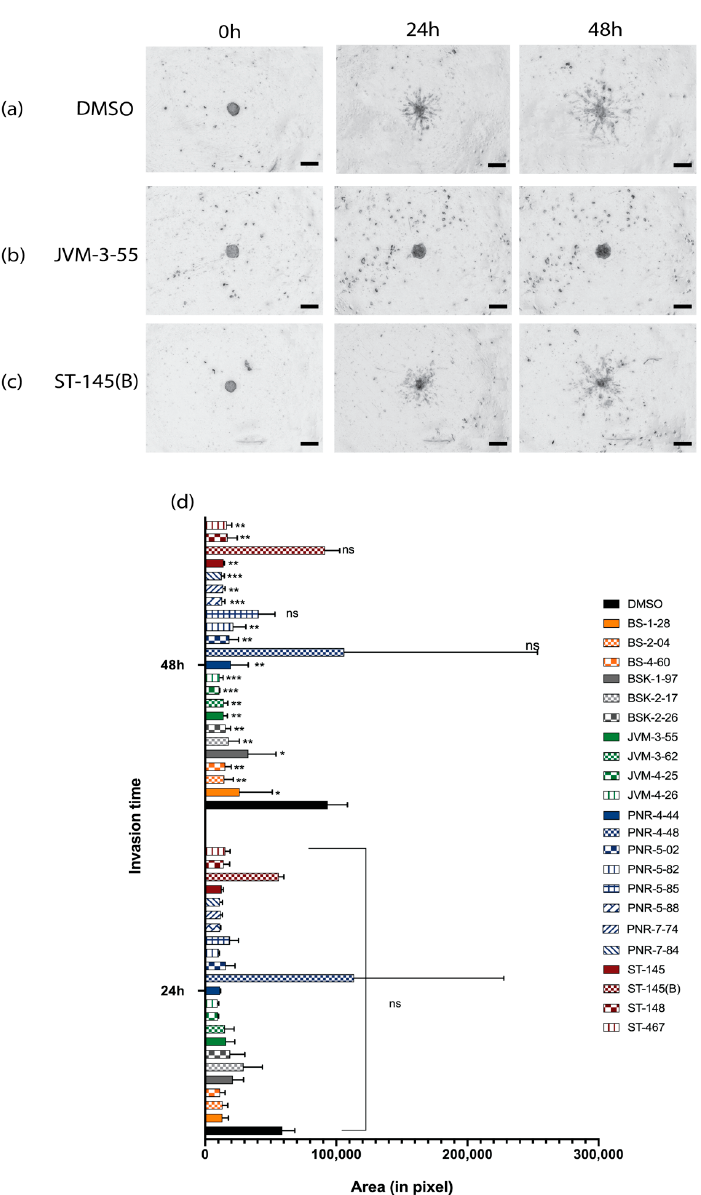
Figure 3. Evaluation of invasion ability and implementation of an automatic invasion analysis assay. Shown are brightfield images recorded on Cytation 5, using a 4× objective lens, overlayed images from z-stack of embedded spheroids in a basement membrane matrix for 0, 24, and 48 h for ( a ) DMSO, ( b ) JVM-3-55, and ( c ) ST-1459(B). Spheroids are large dark bodies in the center of images, and invading cells are smaller dark protrusions from the central spheroid core. ( d ) Quantitation of invasion was determined by the automatic measurement of the area of cells that invaded the matrix (in pixels) for the different times of incubation (0, 24, and 48 h). Statistical analysis of significance was done using two-way ANOVA with the control (DMSO) for the different times of invasion control as the comparative model with the Dunnett model, ns (non-significant) for adjusted p > 0.05, * for adjusted p ≤ 0.05, ** for adjusted p ≤ 0.01, *** p ≤ 0.001 For each experiment, n = 3. Scale bar: 200 µ m, brightfield images were recorded on Cytation 5 using a 4 × objective